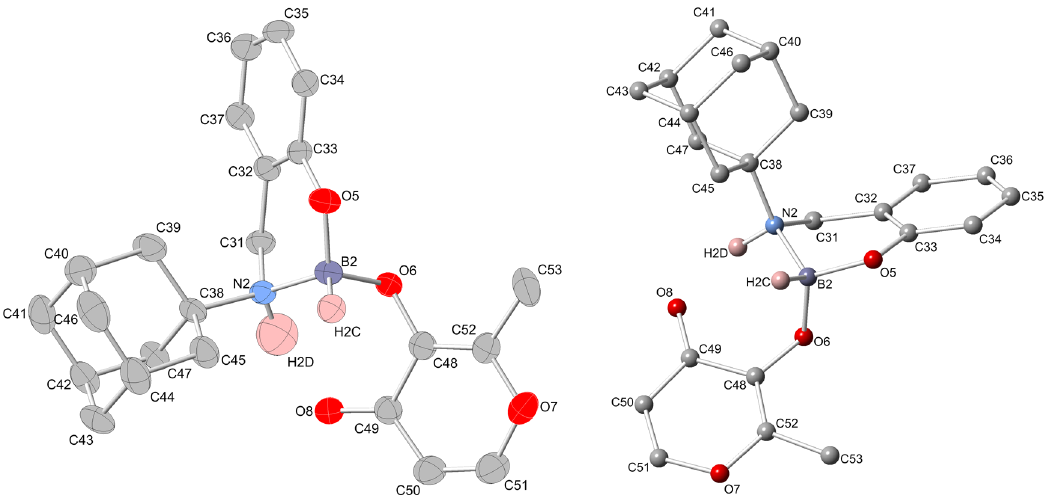
Figure 4. Two views of one of the molecules of 2a within the unit cell with ellipsoids ( left ) drawn at the 50% probability level and hydrogen atoms omitted for clarity. Selected bond distances (Å) and angles (°) for 2a : B(1)–O(1) 1.452(7), B(1)–O(2) 1.478(7), B(1)–N(1)